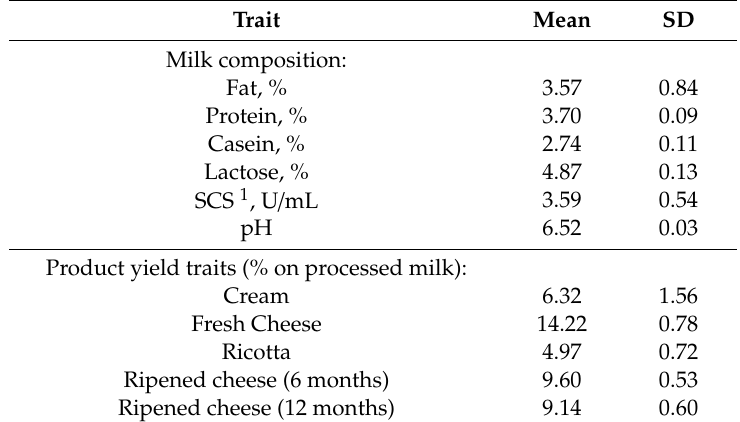
Table 1. Descriptive statistics of the bovine milk composition and of the dairy produce yield. Trait Mean SD Milk composition: Fat, % 3.57 0.84 Protein, % 3.70 0.09 Casein, % 2.74 0.11 Lactose, % 4.87 0.13 SCS 1 , U / mL 3.59 0.54 pH 6.52 0.03 Product yield traits (% on processed milk): Cream 6.32 1.56 Fresh Cheese 14.22 0.78 Ricotta 4.97 0.72 Ripened cheese (6 months) 9.60 0.53 Ripened cheese (12 months) 9.14